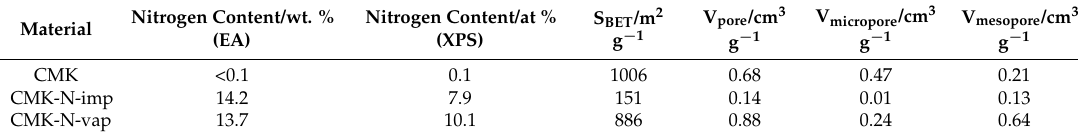
Table 1. Physico-chemical features of N-doped ordered mesoporous carbon materials.